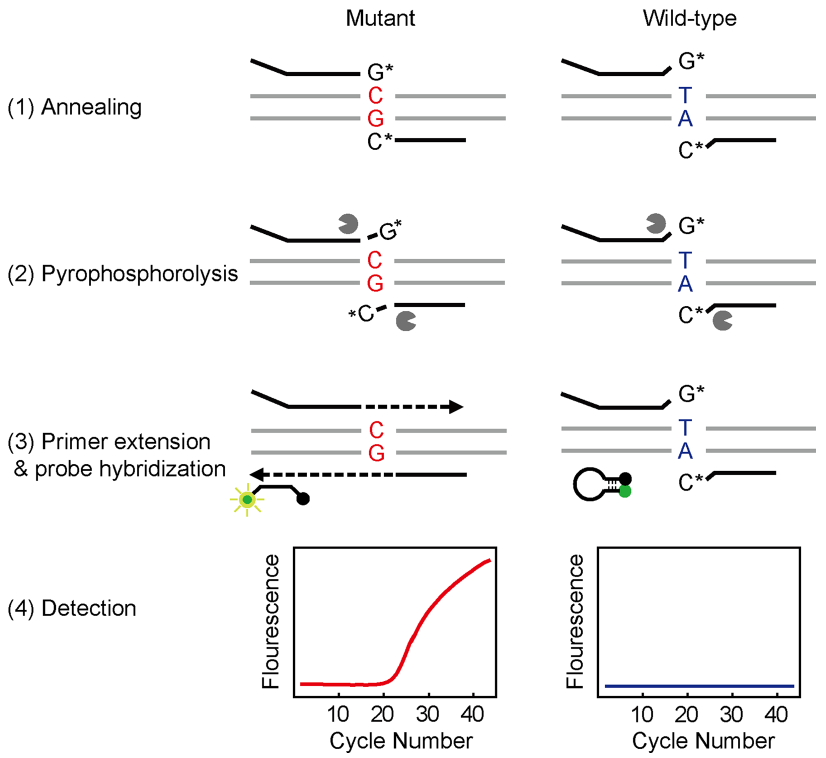
Figure 1. Working principle of real-time Bi-PAP. The working principle is schematically illustrated for the detection of a mutant template (shown as GC-containing, left panel) using a pair of Bi-PAP primers and a molecular beacon. The four steps: primer annealing, pyrophosphorolysis, primer extension/probe hybridization, and fluorescence detection, are shown from the top to bottom. As a result, fluorescence generated from the probe hybridization is detected in the form of amplification profile. In case of a wild-type template (shown as TA-containing, right panel), two Bi-PAP